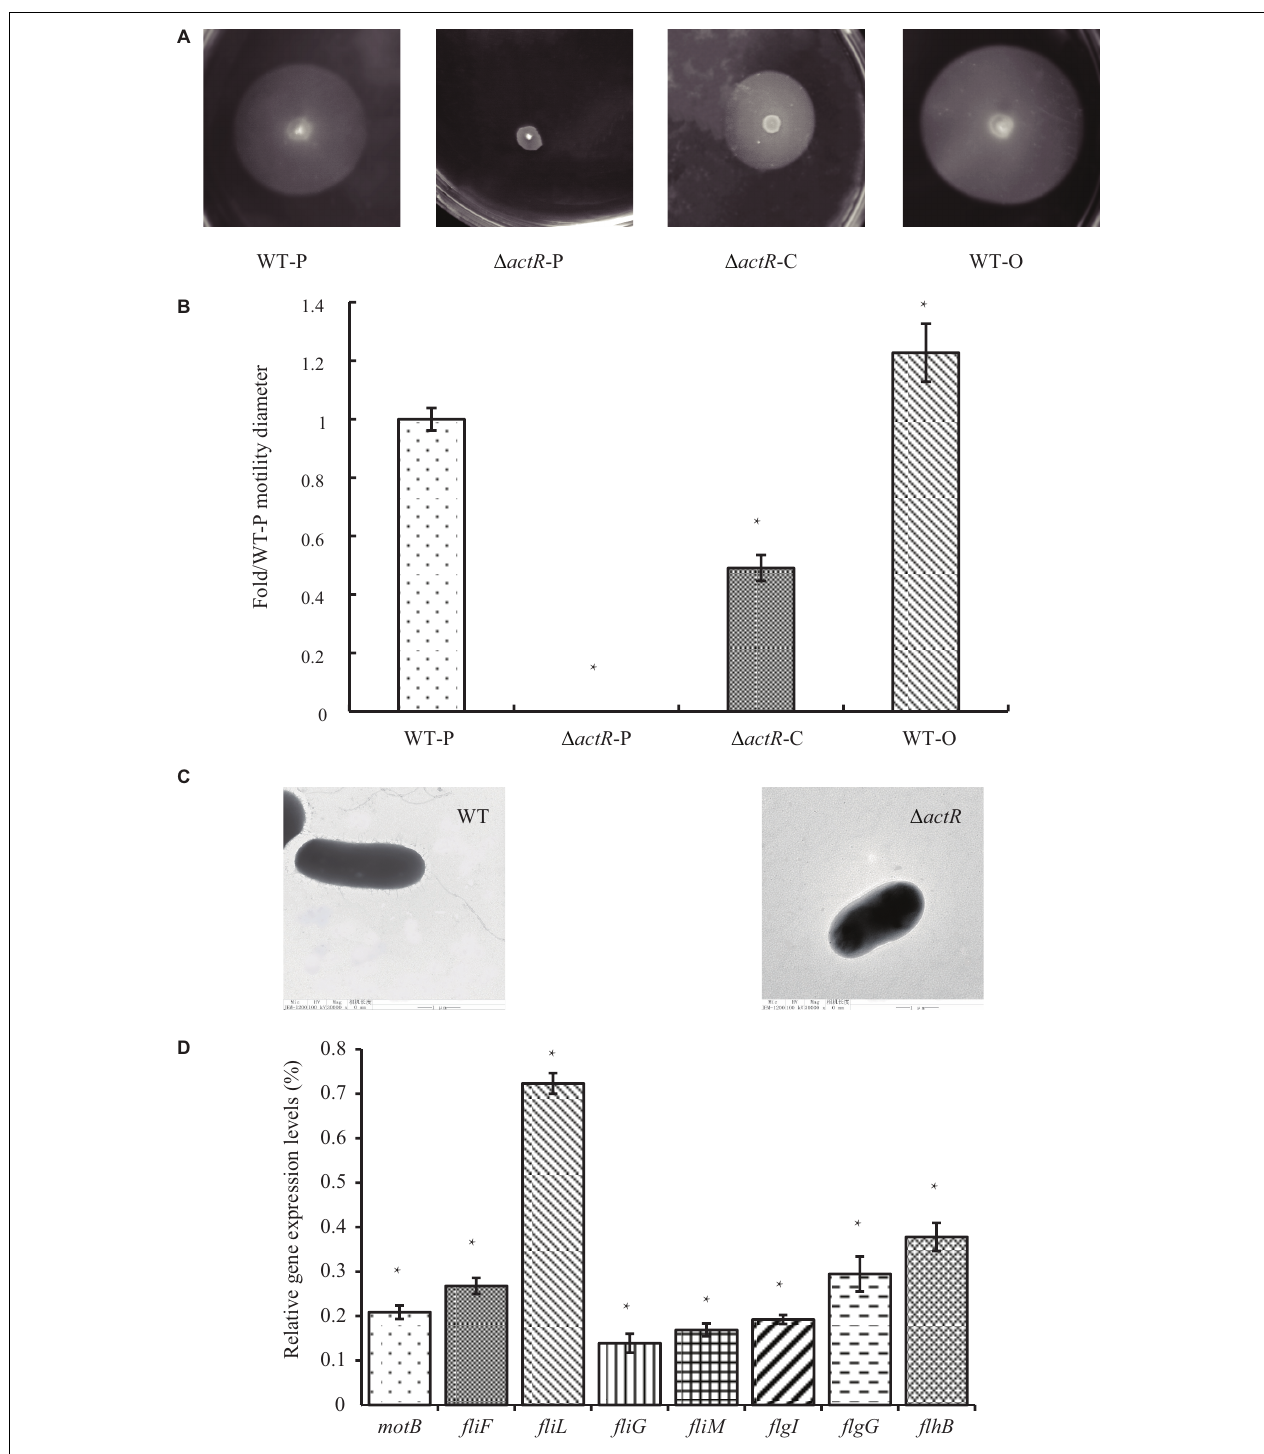
FIGURE 3 | ActR was required for swimming motility and flagellar biosynthesis in Azorhizobium caulinodans . (A) Representative images of the bacterial motility rings in soft agar plates, including the wild-type (WT) strain (WT-P), the (cid:49) actR strain ( (cid:49) actR -P), the complemented strain ( (cid:49) actR -C), and the actR -overexpressing strain (WT-O). (B) Quantitative analysis of the swimming motility abilities. Bar plot represents the mean and SD of fold change about the bacterial motility ring diameter compared with that of WT-P. (C) Representative images obtained by transmission electron microscopy using cells from the WT and (cid:49) actR strains. Scale bar represents 1 µ m. (D) Relative expression of flagellar genes ( motB , fliF , fliL , fliG , fliM , flgI , flgG , and flhB ) in the (cid:49) actR mutant strain compared with that of WT. Bar plot represents the mean and SD of the gene expression level. Means and SDs of fold change and gene expression were obtained from at least three independent experiments. Student’s t -test; *represents significant difference at p < 0.05.